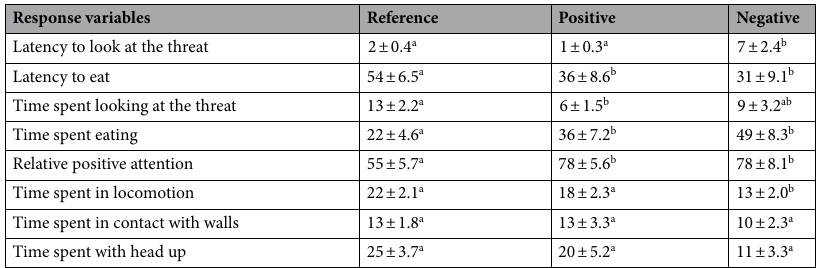
Table 4. Average ± s.e.m. of each behavioural response observed during the Attention Bias Tasks according to the housing conditions. Different letters indicate statistical differences between the housing conditions and were extracted from post-hoc testing (p < 0.05 after Bonferroni correction).